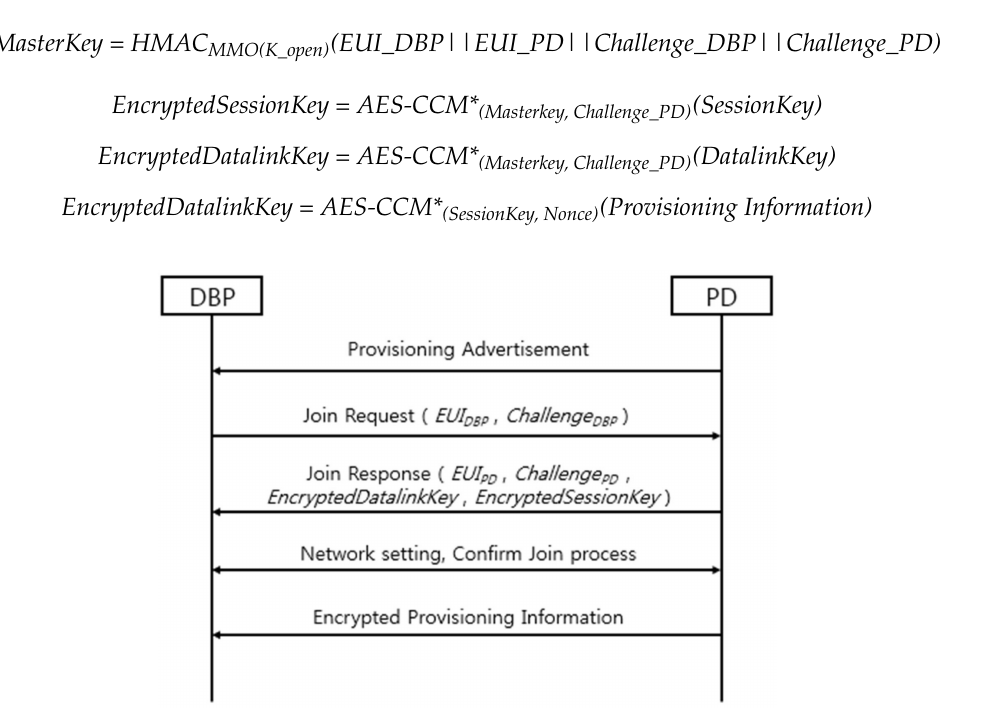
Figure 2. Sequence diagram for the ISA 100.11a standard’s over-the-air (OTA) provisioning process using